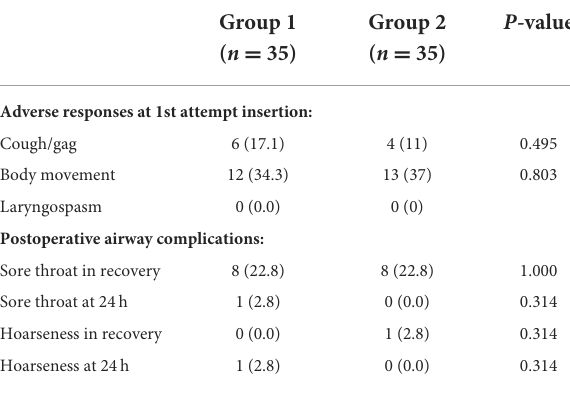
TABLE 3 Adverse response during 1st attempt insertion and postoperative airway